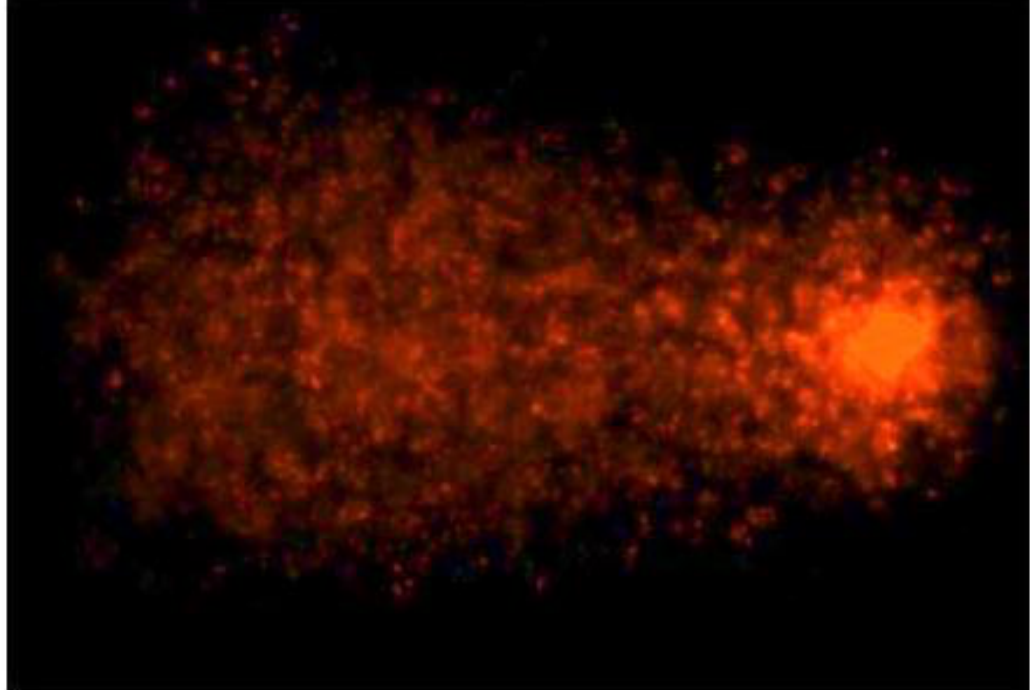
Figure 2. Comet tail DNA in human sperm cell analyzed using “OpenComet” software .